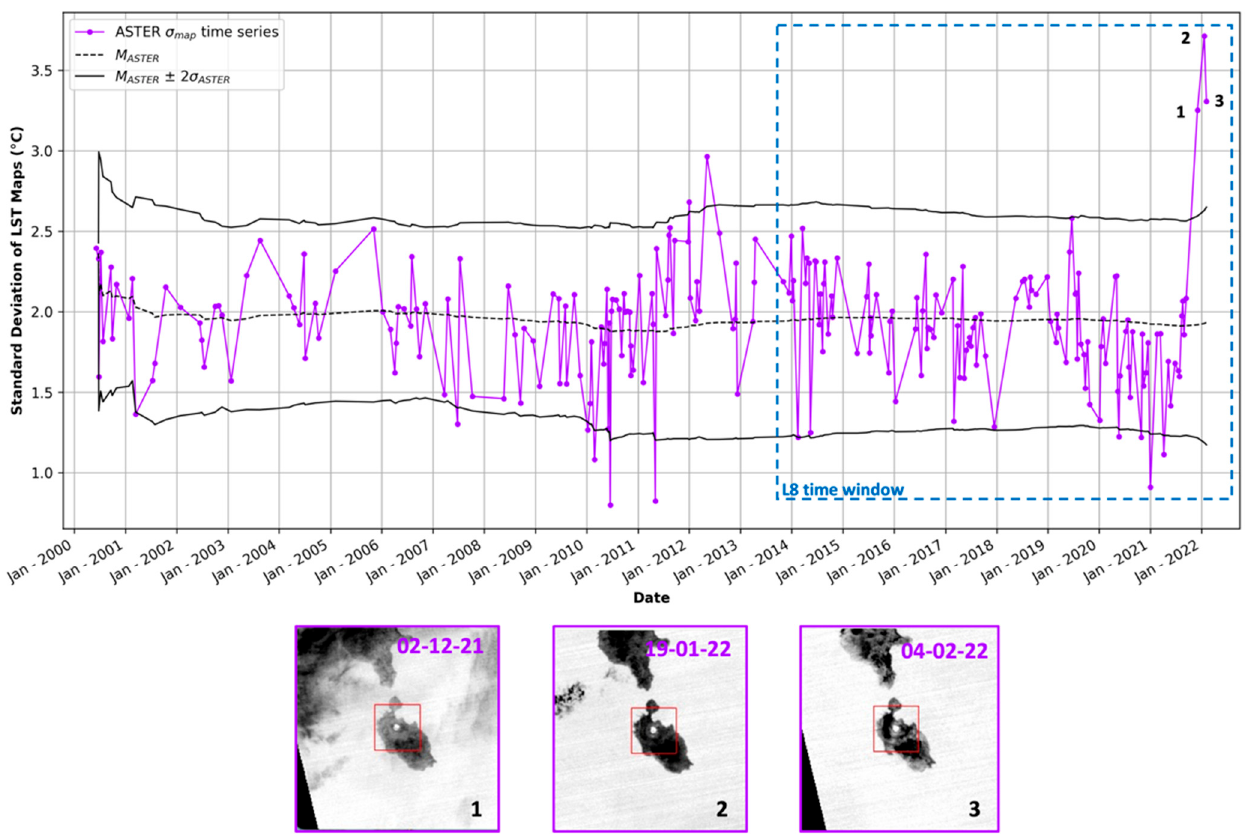
Figure 11. σ ASTER and M ASTER value for the entire ASTER dataset (Up): Visual analysis for the 2 December 2021, 19 January 2022, and 4 February 2022, outliers (down, 1; 2; 3, respectively).